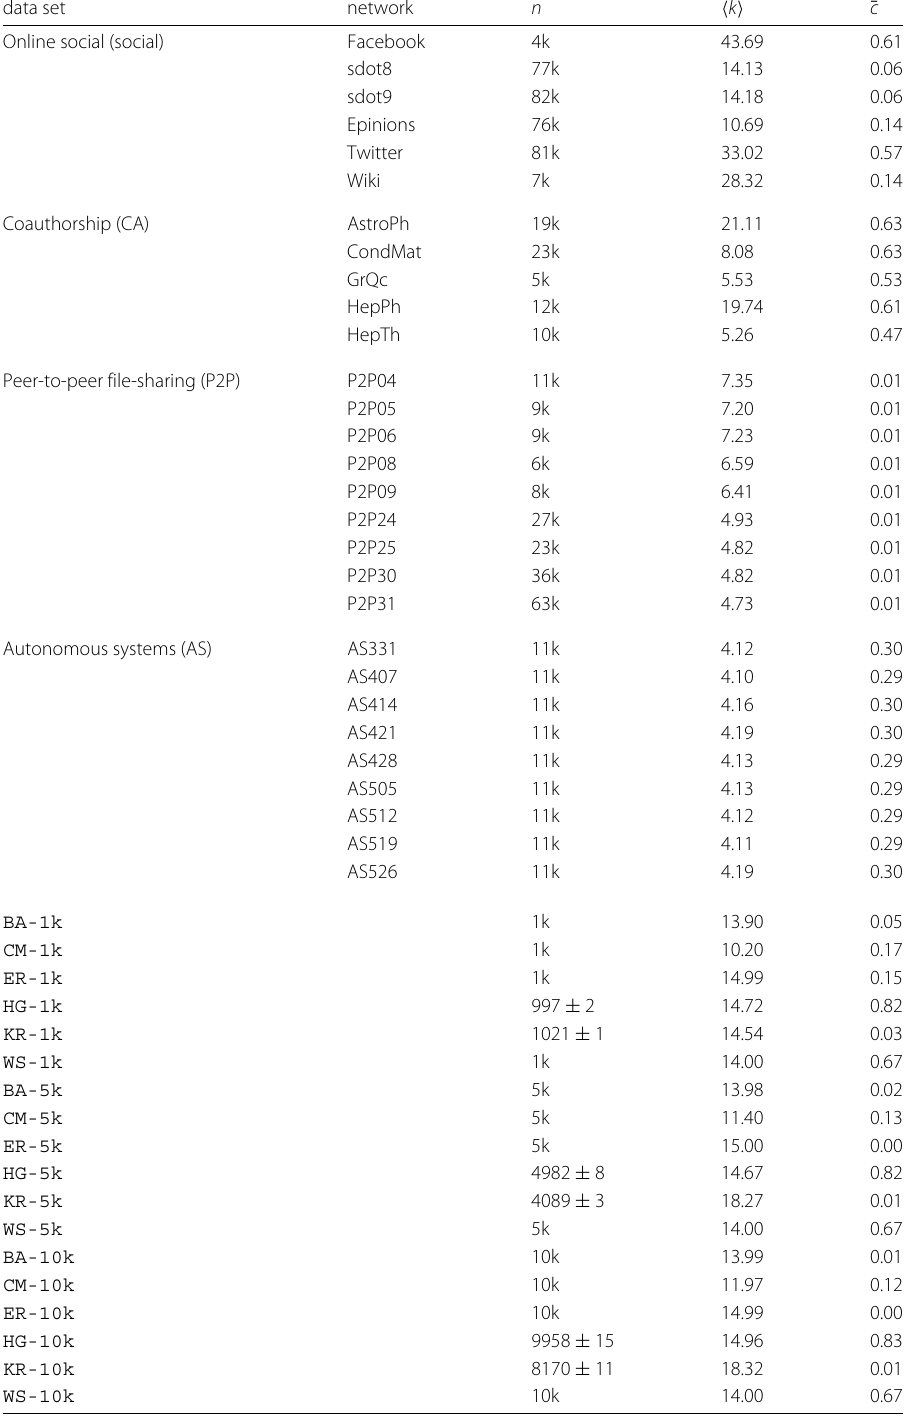
Table 2 Data sets used in this work